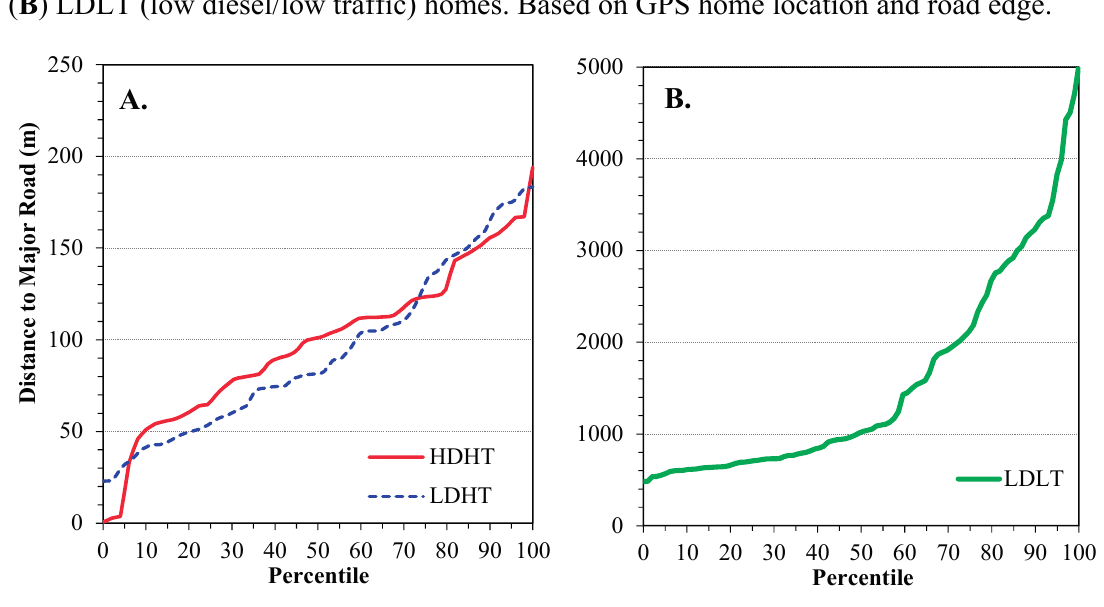
Figure 2. Distribution of distances of homes to major roads for the three traffic exposure groups. ( A ) HDHT (high diesel/high traffic) and LDHT (low diesel/high traffic) homes; ( B ) LDLT (low diesel/low traffic) homes. Based on GPS home location and road